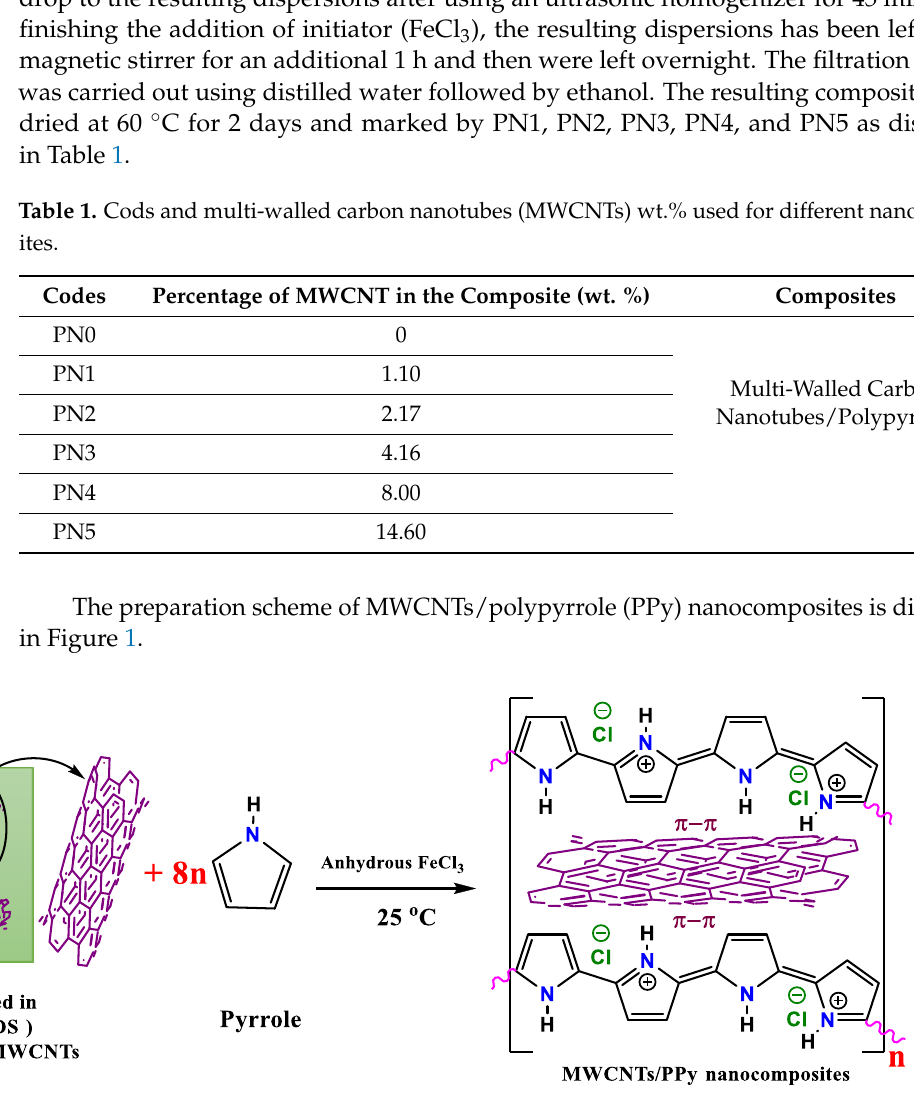
Figure 1. Preparation scheme of polypyrrole/MWCNTs